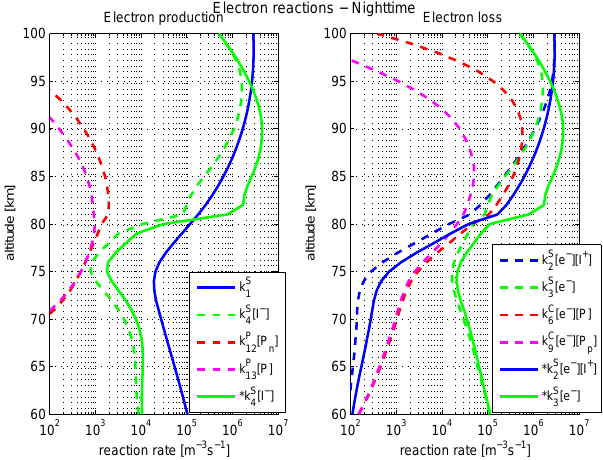
Fig. 10. Altitude profiles of electron production and loss rates. Dashed lines show results of the model run with MSP, solid lines show results of the model run without MSP, see also Eq. 9.